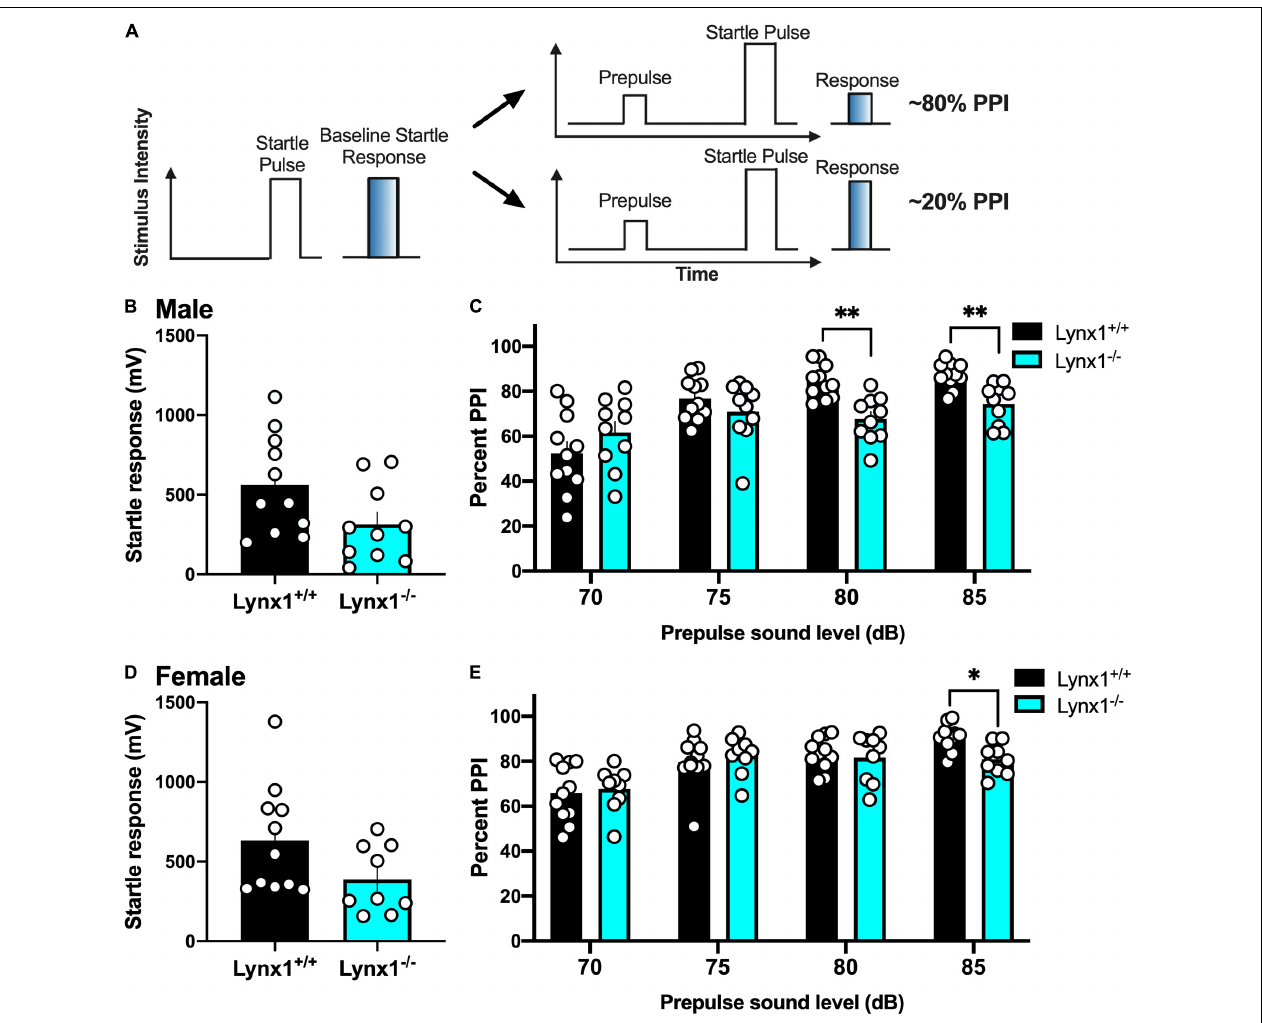
FIGURE 6 | Involvement of lynx1 in sensorimotor gating. (A) Schematic demonstrating the prepulse inhibition (PPI) procedure, in which a lower percent PPI is indicative of decreased sensorimotor gating following the prepulse paired with a startle pulse. Analysis of the baseline startle response (e.g., as represented by the left in A ) was first performed, followed by the prepulse and startle pulse paired sequence, with the prepulse of varying decibels (dB). (B) Male lynx1 + / + and lynx1 − / − mice ( n = 10–11/group) exhibited no differences in their baseline startle response. (C) Following the presence of a prepulse, male lynx1 − / − mice exhibited a decrease in their percent PPI at the 80 and 85 dB prepulse compared to the lynx1 + / + mice. (D) Female lynx1 − / − and lynx1 + / + mice ( n = 9–11/group) exhibited no genotype differences in baseline startle response. (E) Following the presence of a prepulse, female lynx1 − / − mice exhibited a significant decrease in percent PPI at the 85 dB prepulse compared to the lynx1 + / + mice. ∗ p < 0.05, ∗∗ p < 0.01. Individual data points shown as white circles, and the bars represent mean ± SEM. Image created with